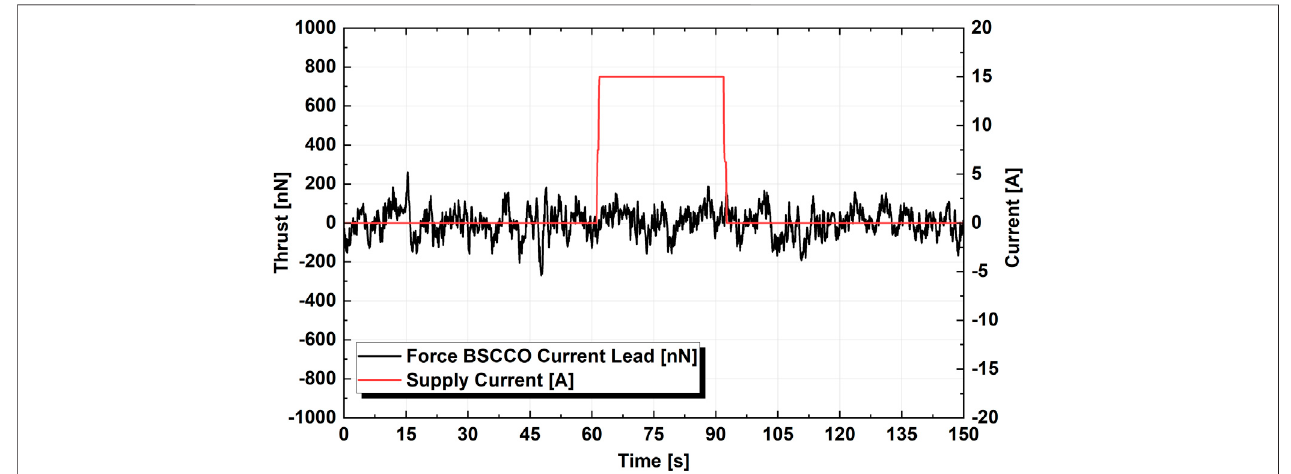
Frontiers in Physics |